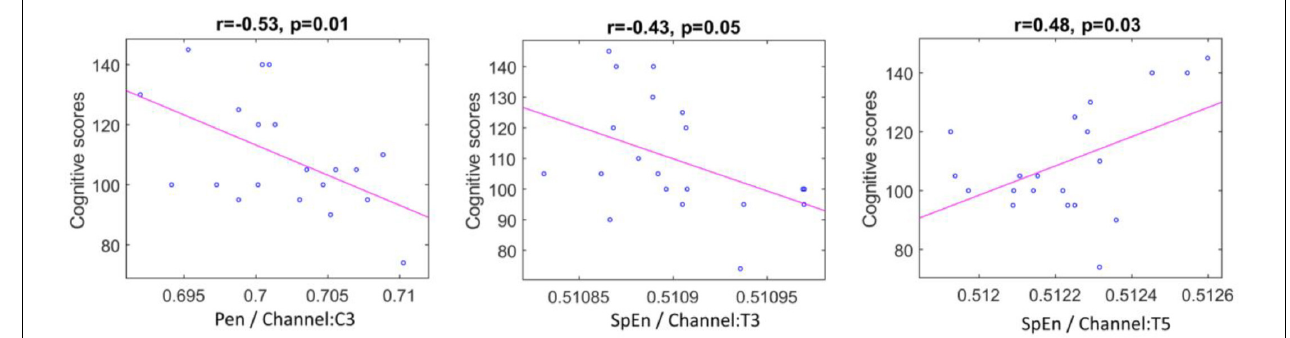
FIGURE 7 | Scatter plots representing correlation between the significant entropy features and cognitive scores.